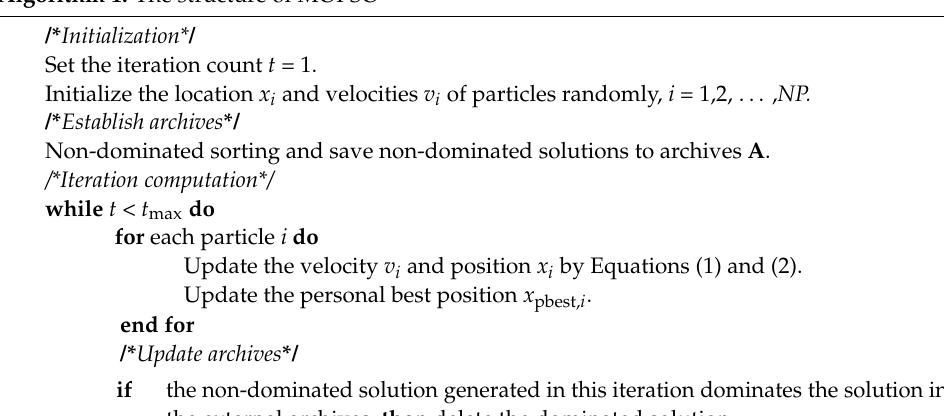
Algorithm 1. The structure of